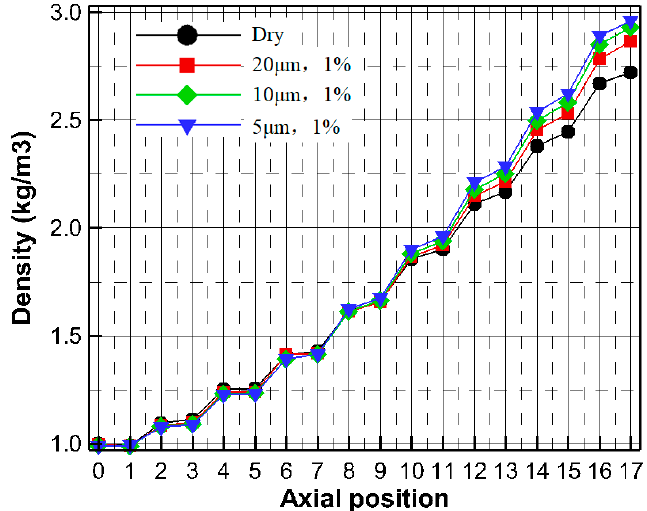
Figure 31. Axial variation of gas density under injecting water of different droplet sizes.